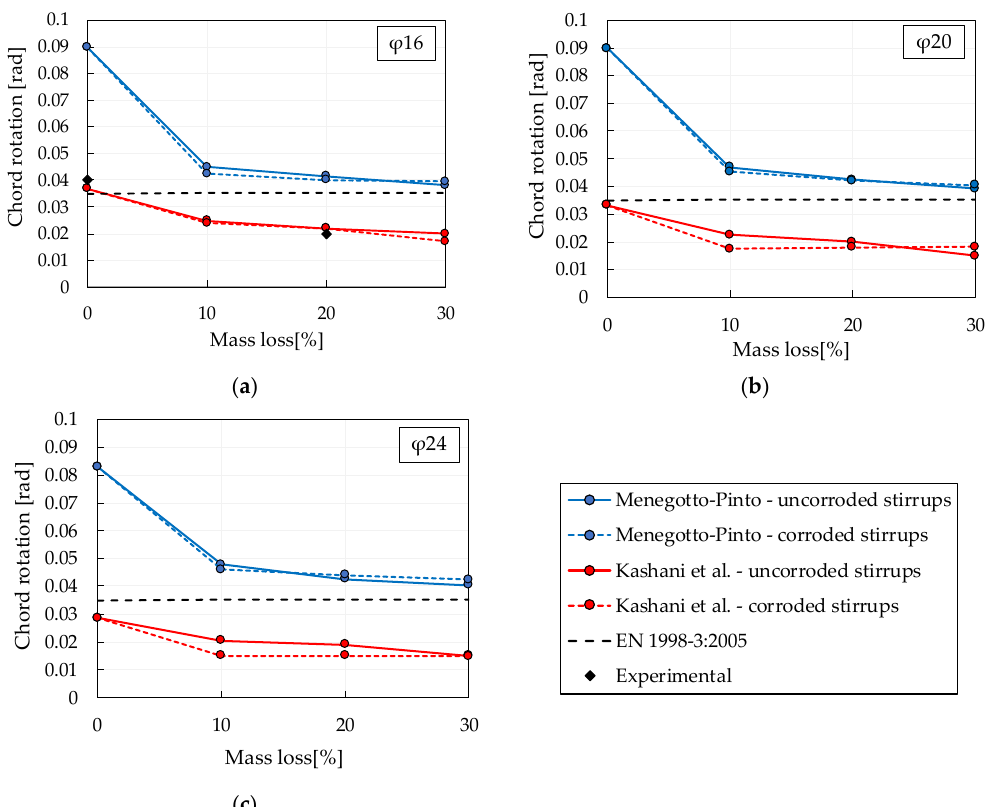
Figure 9. Comparison of ultimate chord rotation in the function of the mass loss for different values of longitudinal reinforcement diameter: ( a ) φ16, ( b ) φ20, and ( c ) φ24.